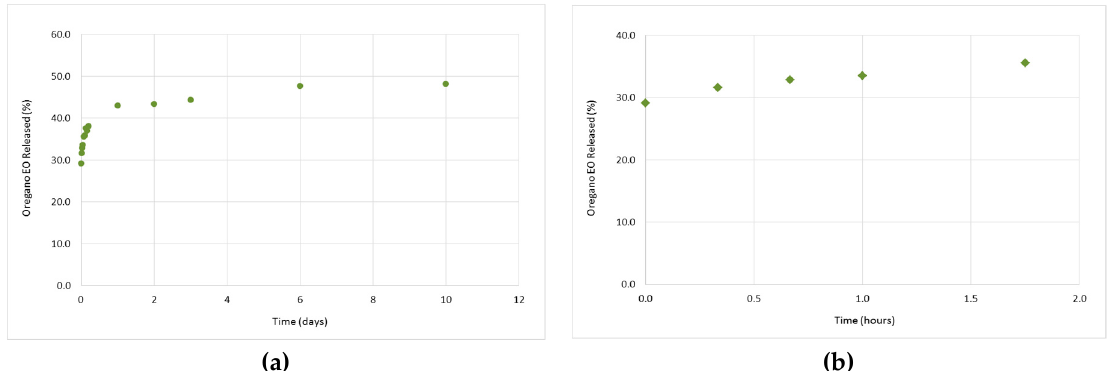
Figure 8. Release profile of the encapsulated oregano EO at 37 °C and pH 5.5, during 11 days ( a ), as well as at the first 1 h and 45 min of the experiment ( b) .